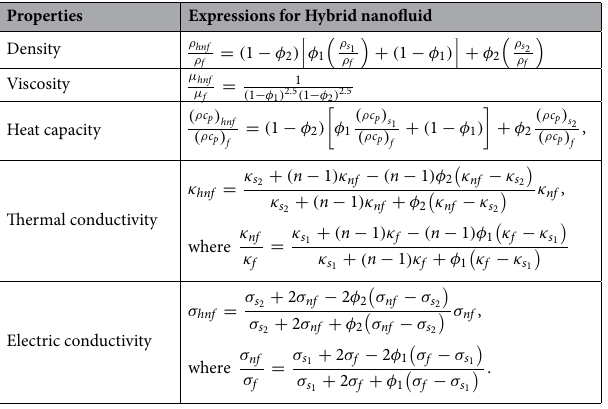
Table 1. Empirical relations for thermophysical characteristics of hybrid nanofluid 26,27 .